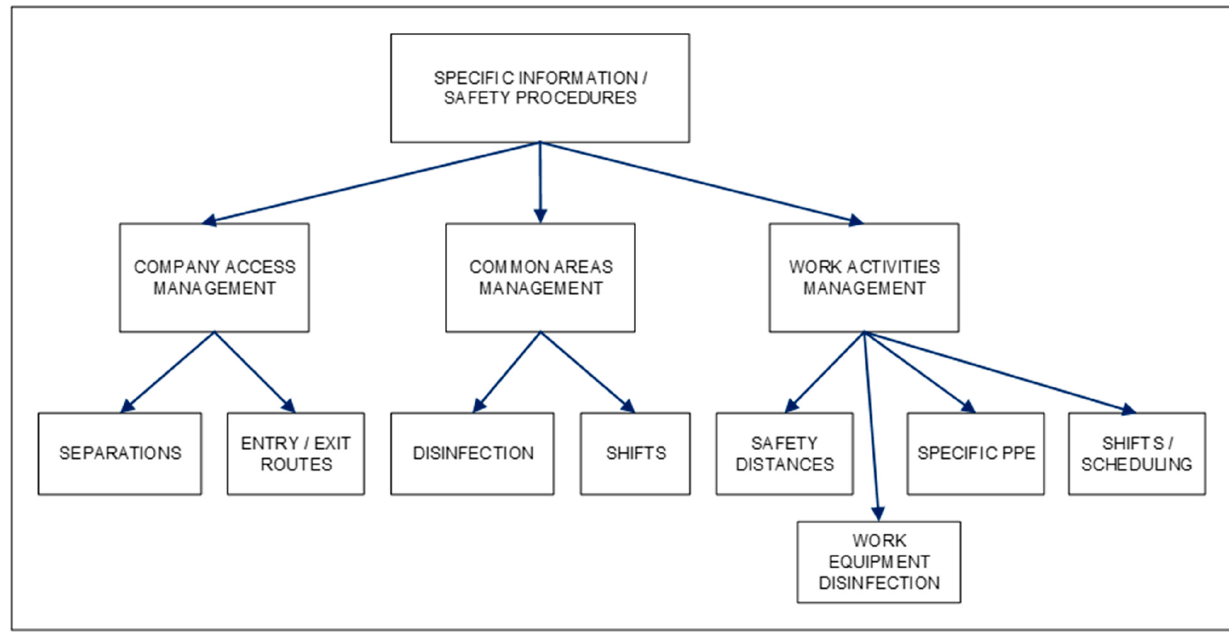
Figure 2. Scheme of occupational safety measures in agricultural